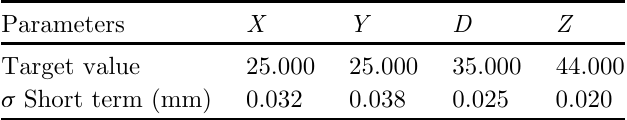
Fig. 5. Digital three-dimensional measuring machine. Table 4. Estimation of the short term dispersion of the process control.